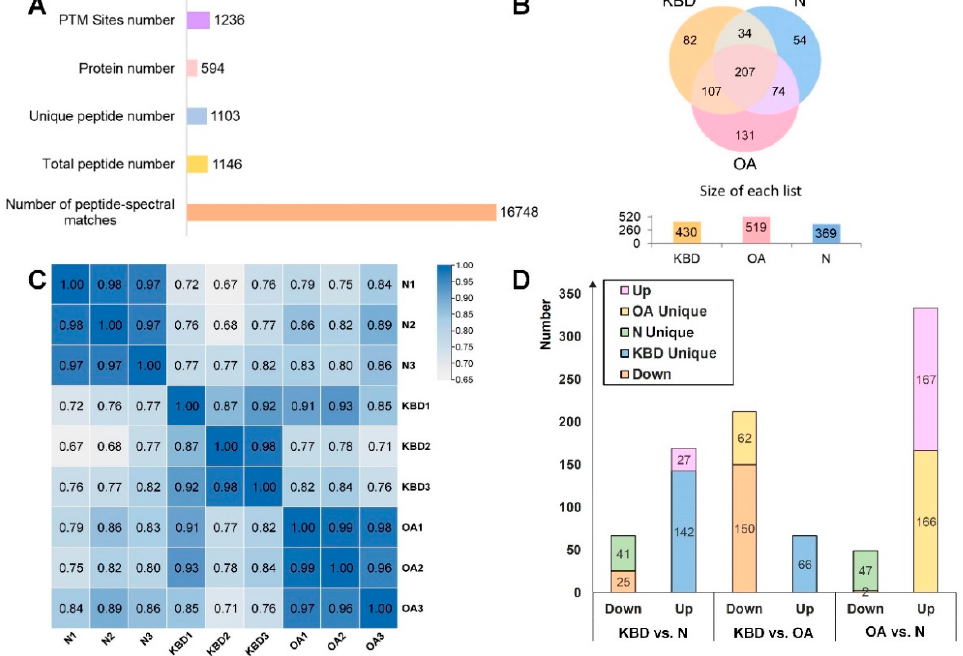
Figure 1. Basic identification information. ( A ) Mass spectrometric identification information. ( B ) The Venn diagram of N-glycopeptides identified in the cartilage of N, OA, and KBD group. ( C ) Correlation analysis of quantitative data. Within the N, OA, and KBD groups, respectively, the similarities within each group were high (0.87–1.00) while similarities among the three groups were low. ( D ) Modified histogram of N-glycopeptides in N, OA, and KBD group.